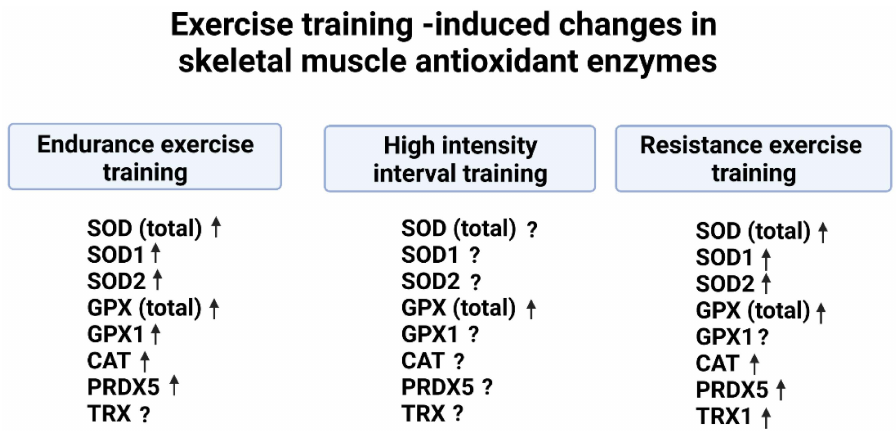
Figure 5. Summary of the effects of exercise training on the abundance/activity of antioxidant enzymes in skeletal muscle. SOD (total) = superoxide dismutase 1 + superoxide dismutase 2; SOD1 = superoxide dismutase 1; SOD2 = superoxide dismutase 2; GPX (total) = all glutathione peroxidase isoforms in fiber; GPX1 = glutathione peroxidase 1; CAT = catalase; Trx1 = Thioredoxin 1; PRDX5 = Peroxiredoxin 5 = PRDX5. Arrows signify exercise-induced increases in antioxidant activity. Question marks (?) indicate that it remains unknown as to whether exercise increases the activity of select antioxidants. Figure created by